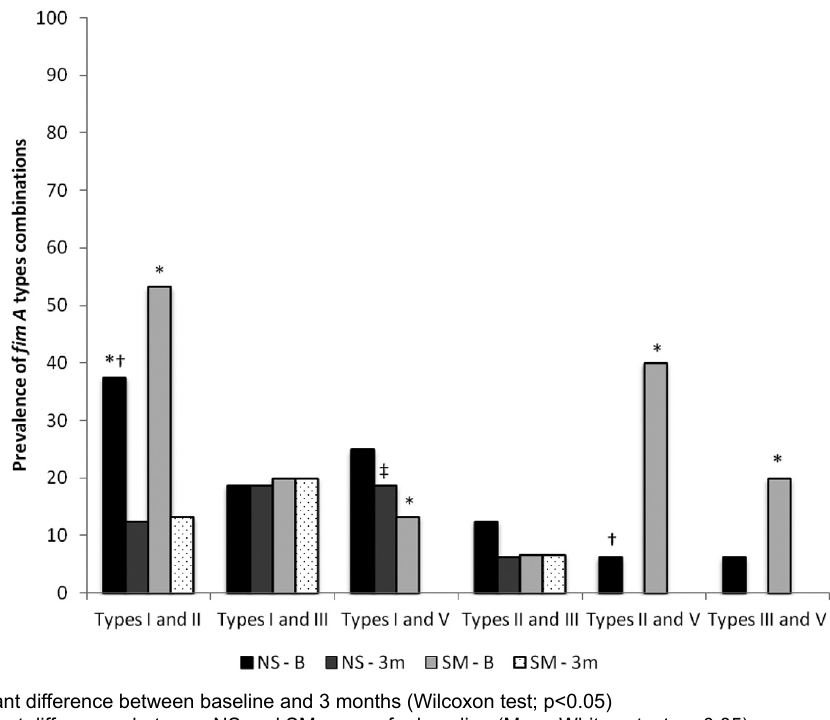
Figure 1- Frequency (%) of combinations of P. gingivalis fimA genes in smokers (SM) and nonsmokers (NS) at baseline and after 3 months of periodontal treatment. Values express percentage of P. gingivalis harboring fimA